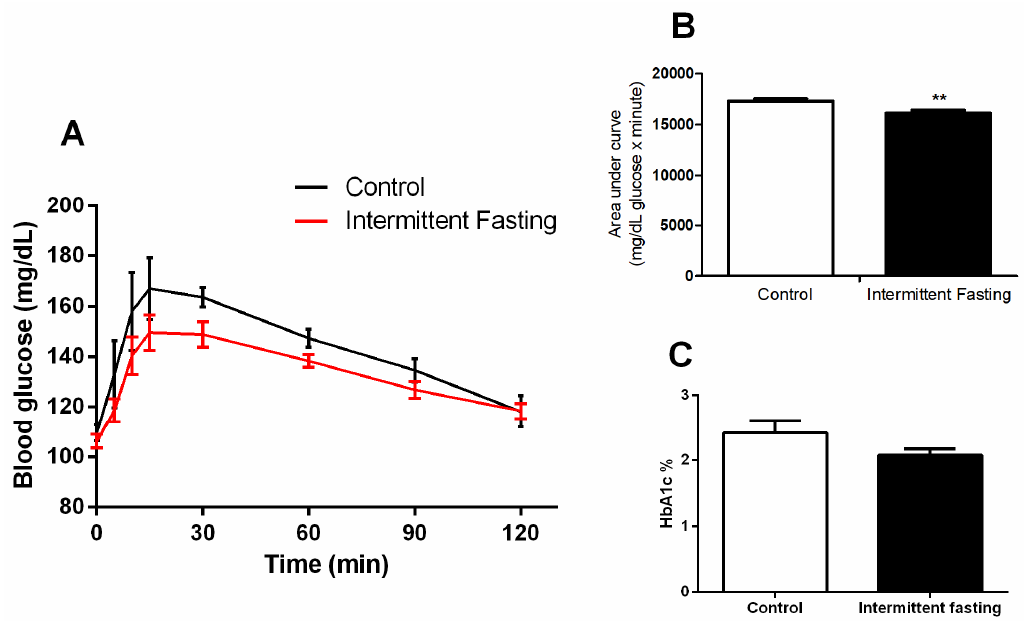
Figure 6. ( A ) Oral glucose tolerance test (oGTT), ( B ) area under curve, and ( C ) hemoglobin A1c (HbA1c) of Wistar rats submitted to IF for 12 weeks. The results are presented as the means ± standard error of the mean (SEM) with 5 di ff erent animals for each group. ** p < 0.005 compared to the control, as indicated by Student’s t-test (B and C), two-way ANOVA followed by Sidak’s multiple comparisons test (A).